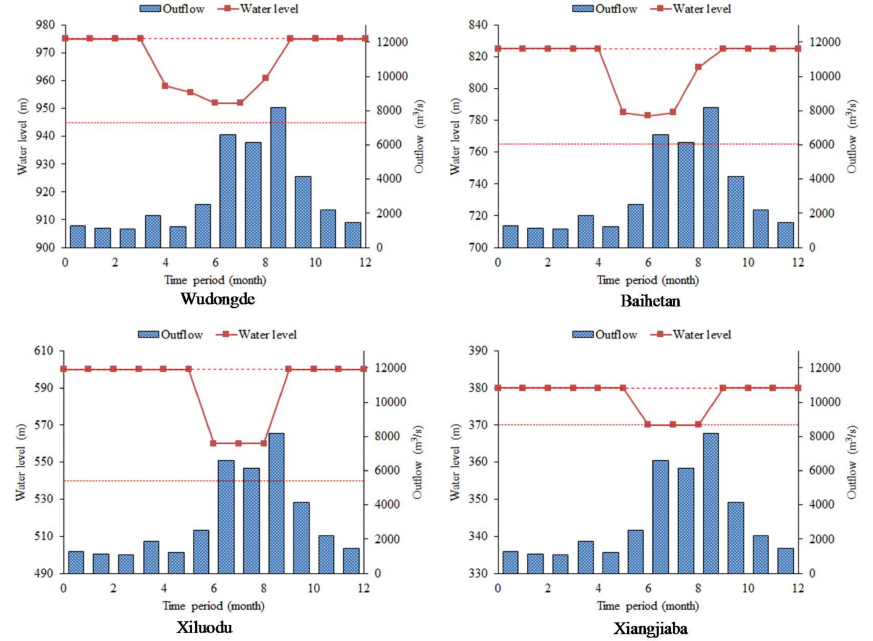
Figure 7. Optimal results in normal year by month.